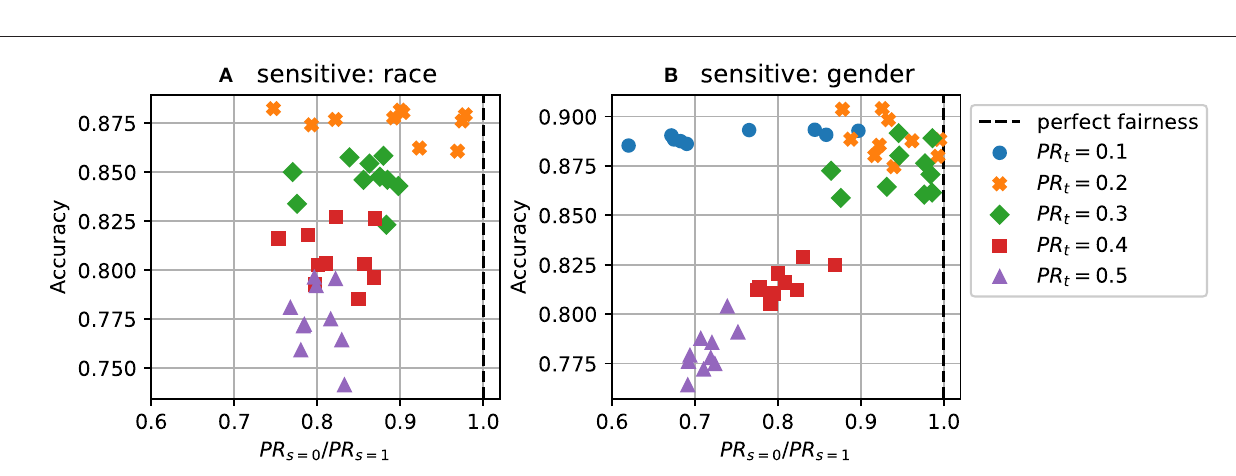
FIGURE 3 | Predictions with different target acceptance rates (demographic parity) for 10 repeats. (A) Disparate impact vs accuracy on Adult dataset using race as the sensitive attribute; (B) Disparate impact vs accuracy using gender.